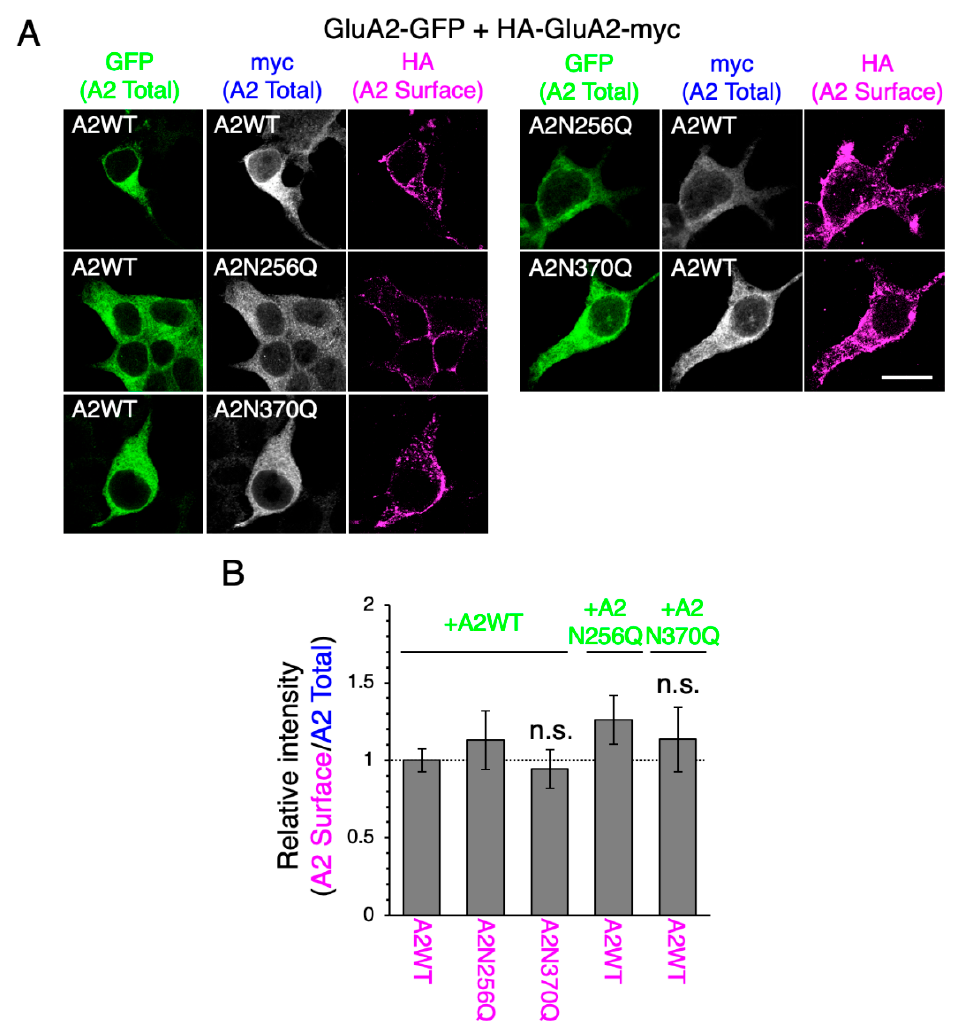
Figure 4. GluA2WT enhances the cell surface expression of GluA2N370Q. ( A ) Representative immunostaining images showing the cell surface WT and mutant (N256Q and N370Q) GluA2 tagged with HA and myc (at the N- and C-terminus, respectively) in HEK293 cells co-expressing GFP-tagged